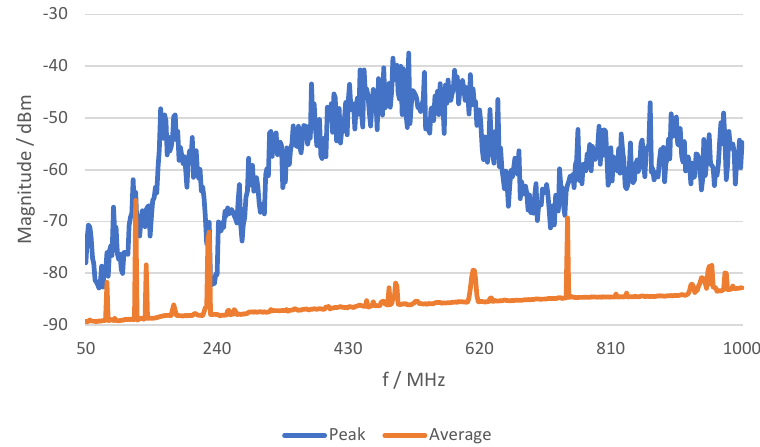
Figure 10. Spectrum Acquired on DN-80 Antenna.